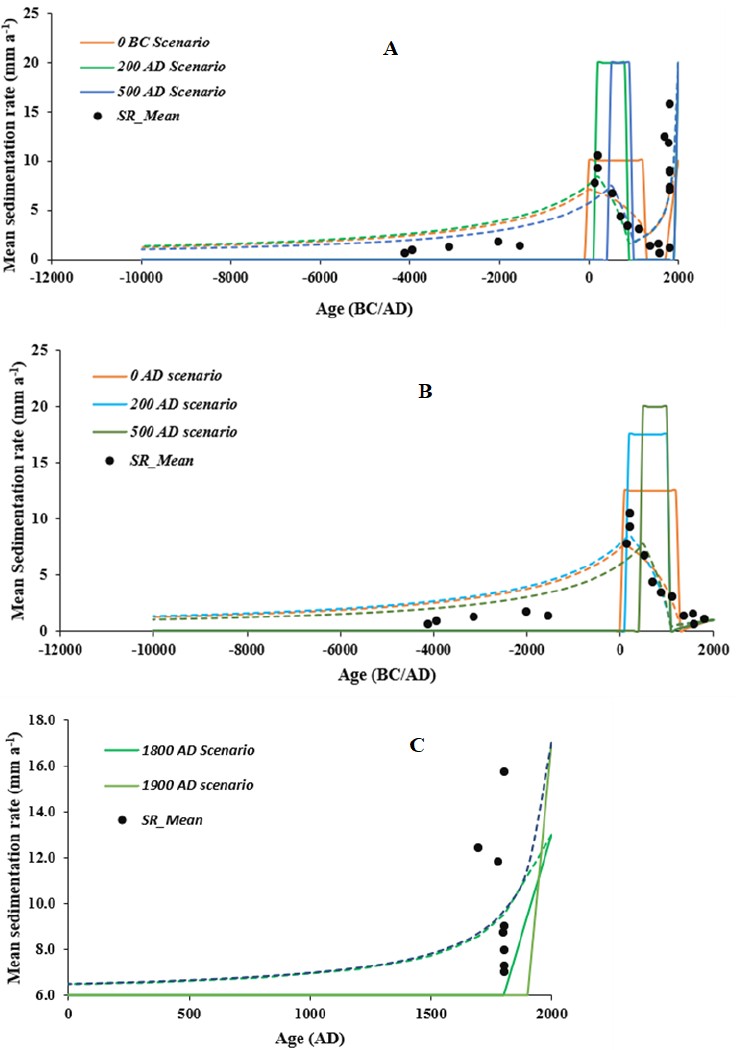
Figure 10. Mean sedimentation rate (black dots) of ( A ) both Chencha and Dembelle, ( B ) Chencha and ( C ) Dembelle, and model results from the mean sedimentation rates SR m modeling approach over the Holocene period. The lines represent the alternative scenarios in the onset of increased and decreased sedimentation rate trends. Model efficiency values for several sedimentation rate scenarios were performed to